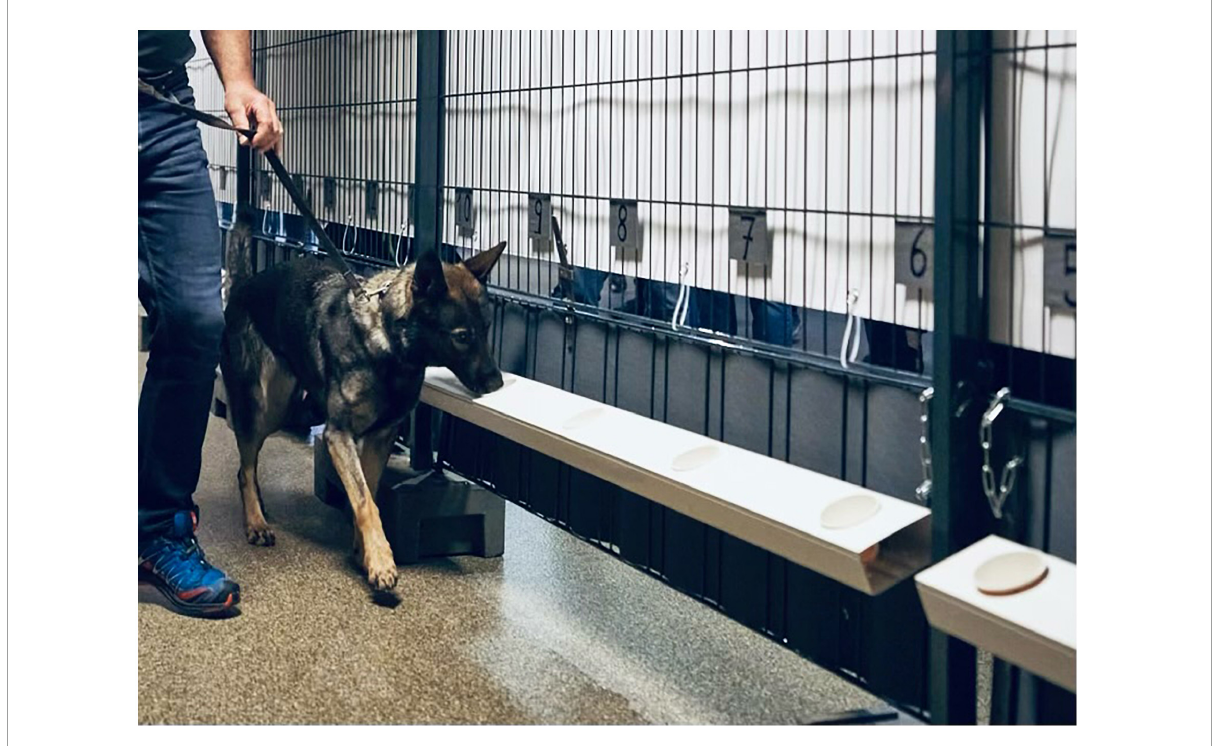
FIGURE2 Dog and its handler working in a line-up